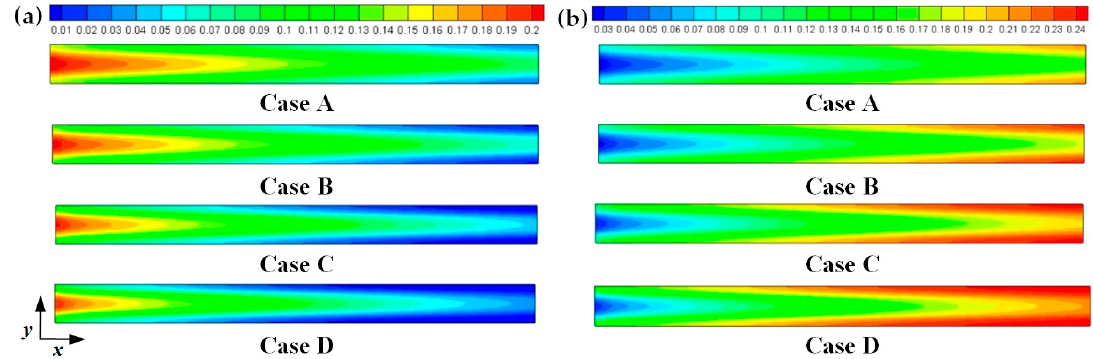
Figure 7. Species mass fraction at the cathode GDL and CL interface of fuel cells (Case A: DL = 5; Case B: DL = 7; Case C: DL = 9; Case D: DL = 11): ( a ) oxygen mass fraction; ( b ) water mass